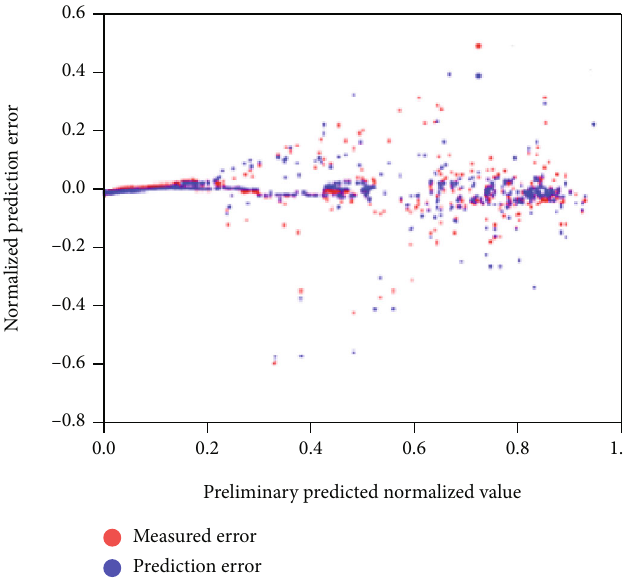
Figure 19: Comparison of error